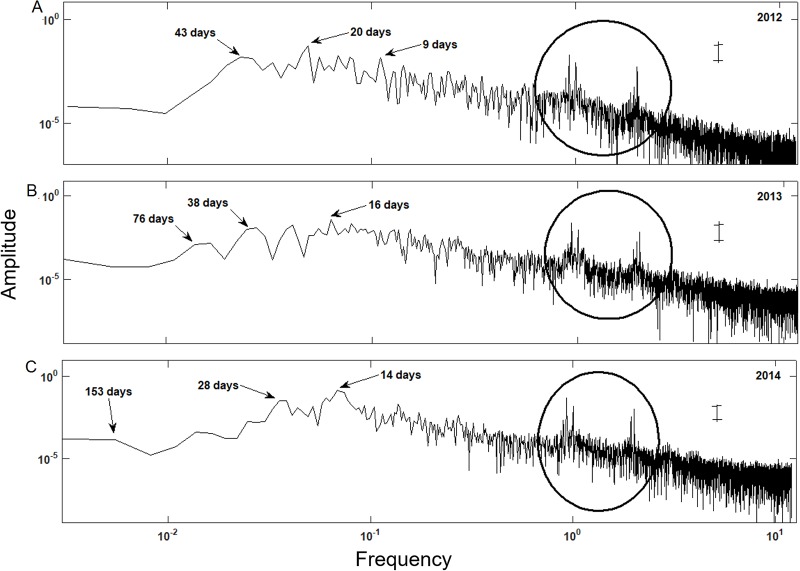
Dominant frequency spectrum for the water level data of the reference site (R) in 2012 (A), 2013 (B) and 2014 (C).The circle indicates the diurnal (left hand peak) and semidiurnal (right hand peak) tides. The black bar indicates the confidence interval.